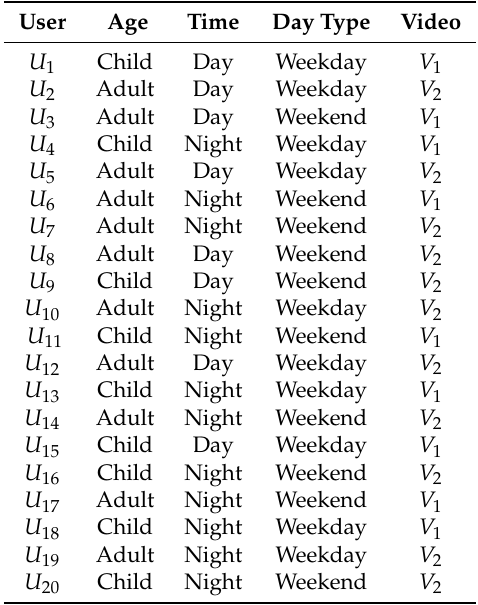
Table 4. Example of contextual sparsity in CAVRS